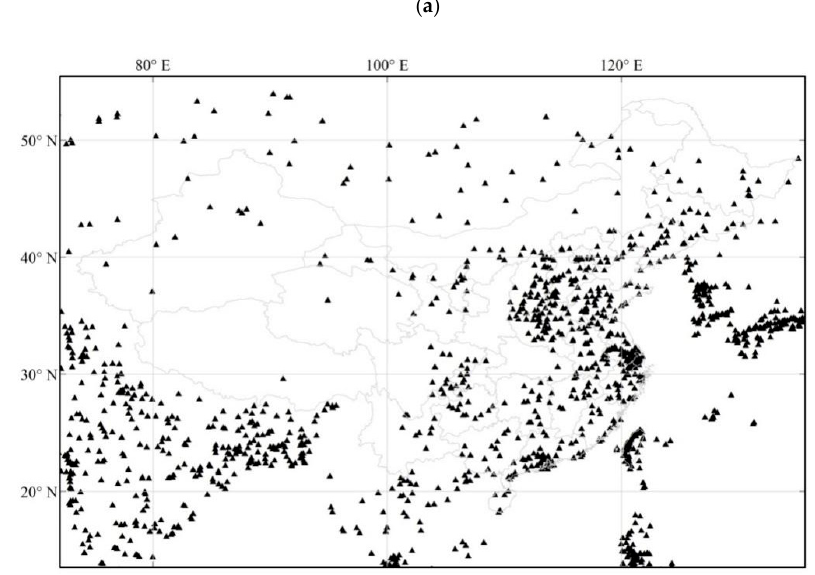
Figure A5. Scatter plots of the bias corresponding to the inventory emissions in 2019 for ( a ) ODIAC in China; ( b ) EDGAR in China where red color is the result of excluding two grids with abnormal emissions in the cities of Shanghai and Shenyang; ( c ) ODIAC in the USA, and ( d ) EDGAR in the USA.